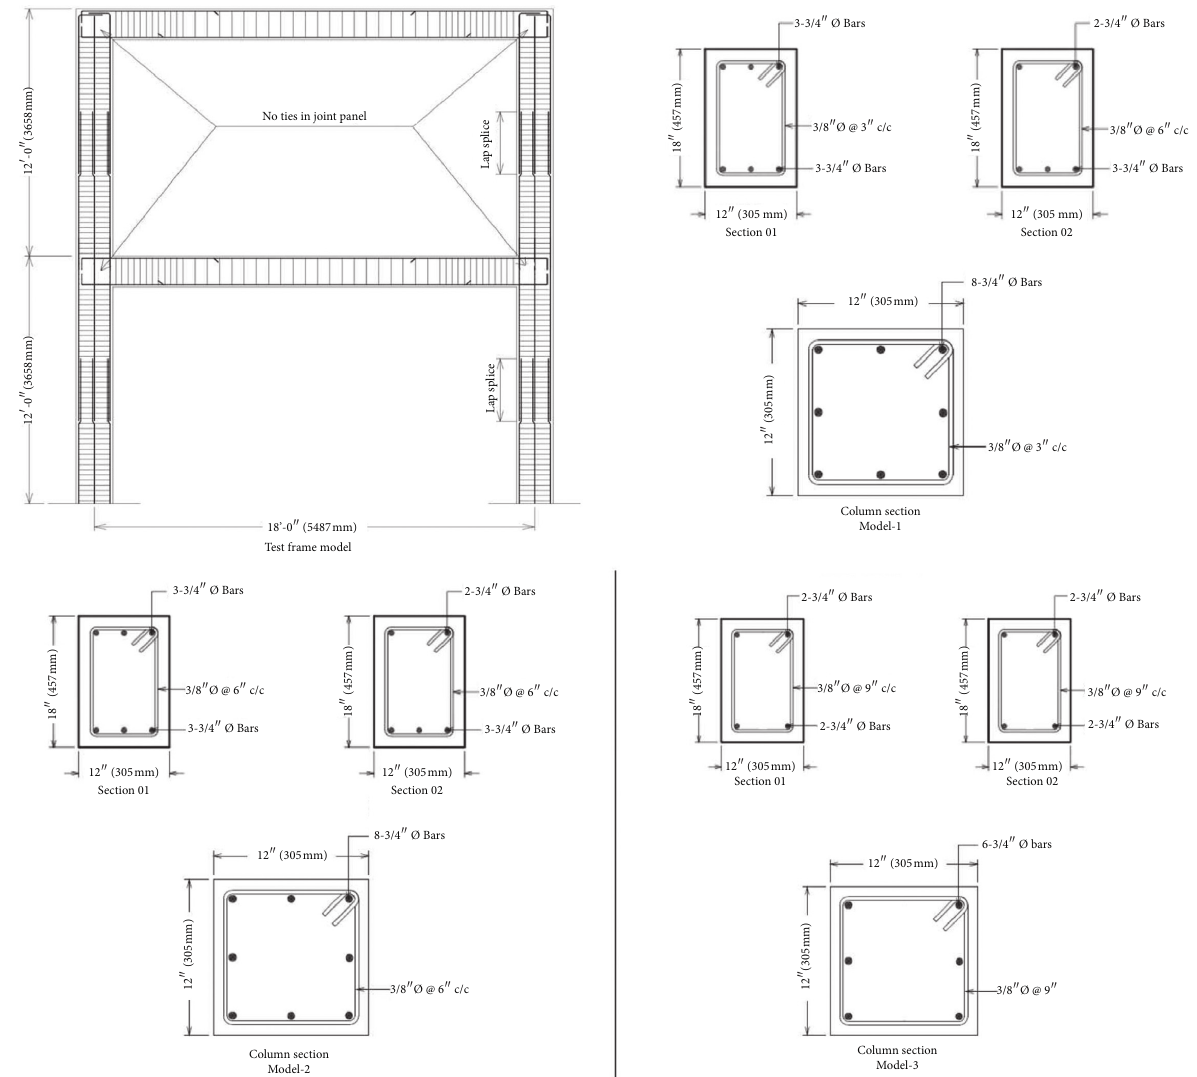
Figure 1: Layout and design configuration of considered frame structures.